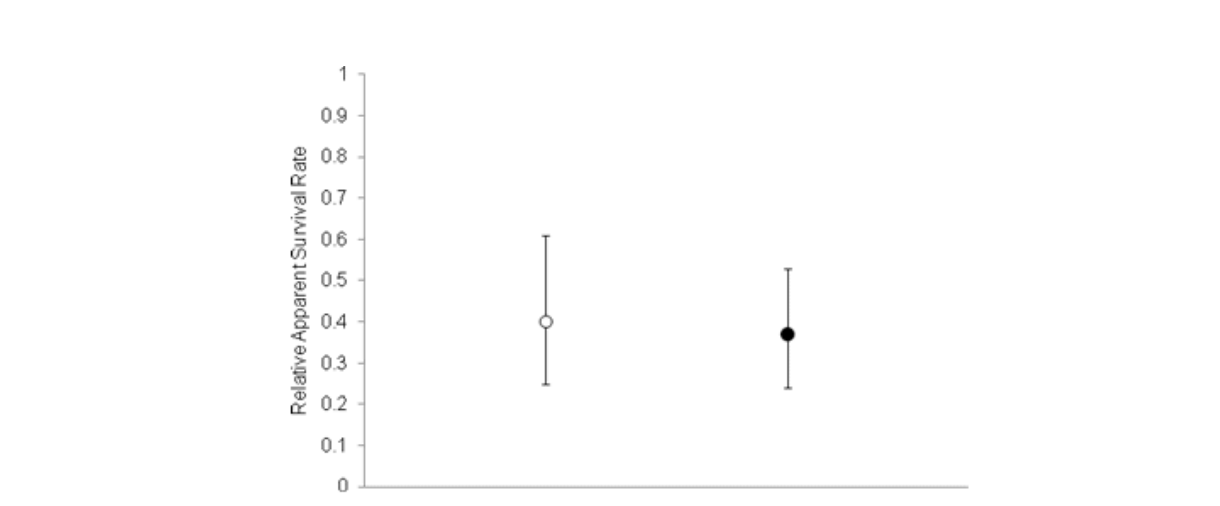
Fig. 4 . Relative apparent survival rate (ratio of apparent annual survival in freeway populations to apparent annual survival in control populations) of male and female squirrel gliders ( Petaurus norfolcensis ) in southeast Australia, 2005–2008. The open circle is the mean estimate with vague priors; the shaded circle is the mean estimate with informative priors for apparent survival in control populations. Bars are 95% credible